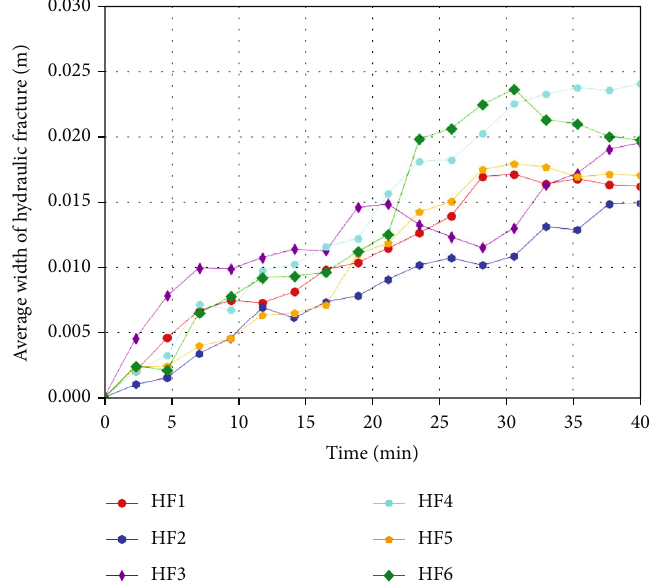
Figure 14: Average fracture width varies with fracturing time.